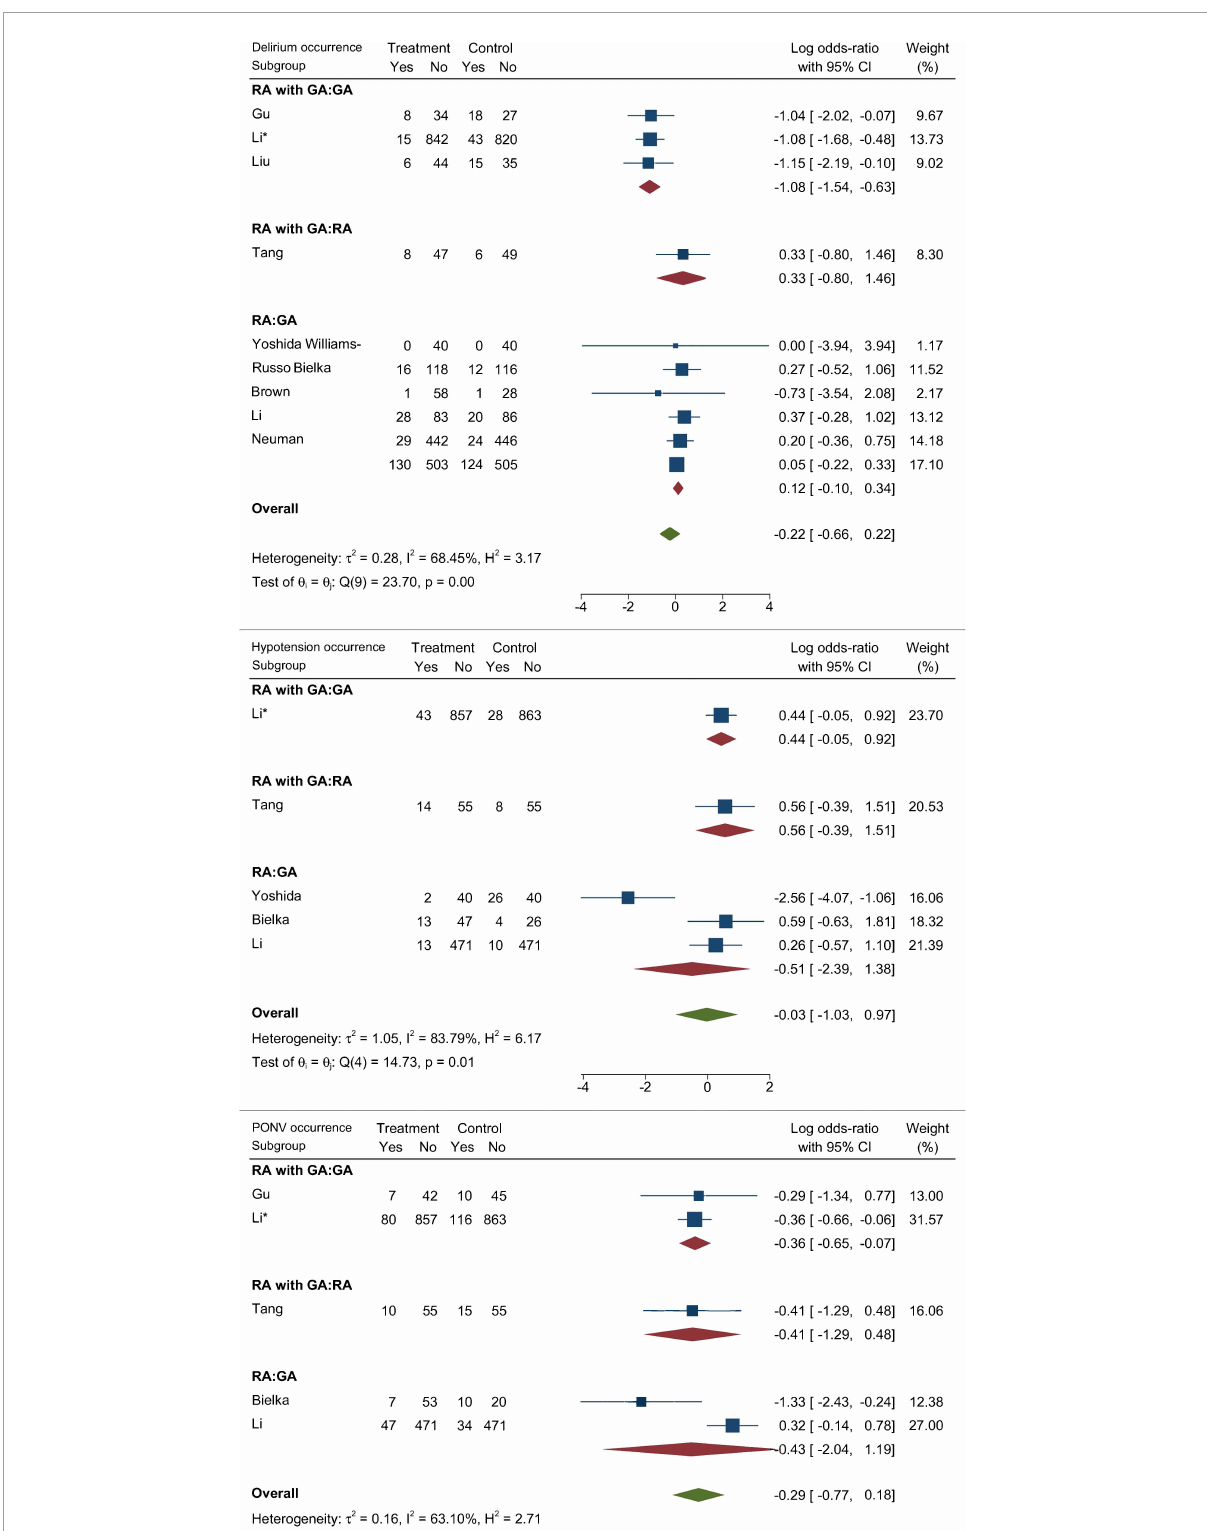
FIGURE3 Pairwise meta-analysis results of the occurrence of POD, postoperative hypotension, and PONV (Data are expressed as Log OR, 95%CI).